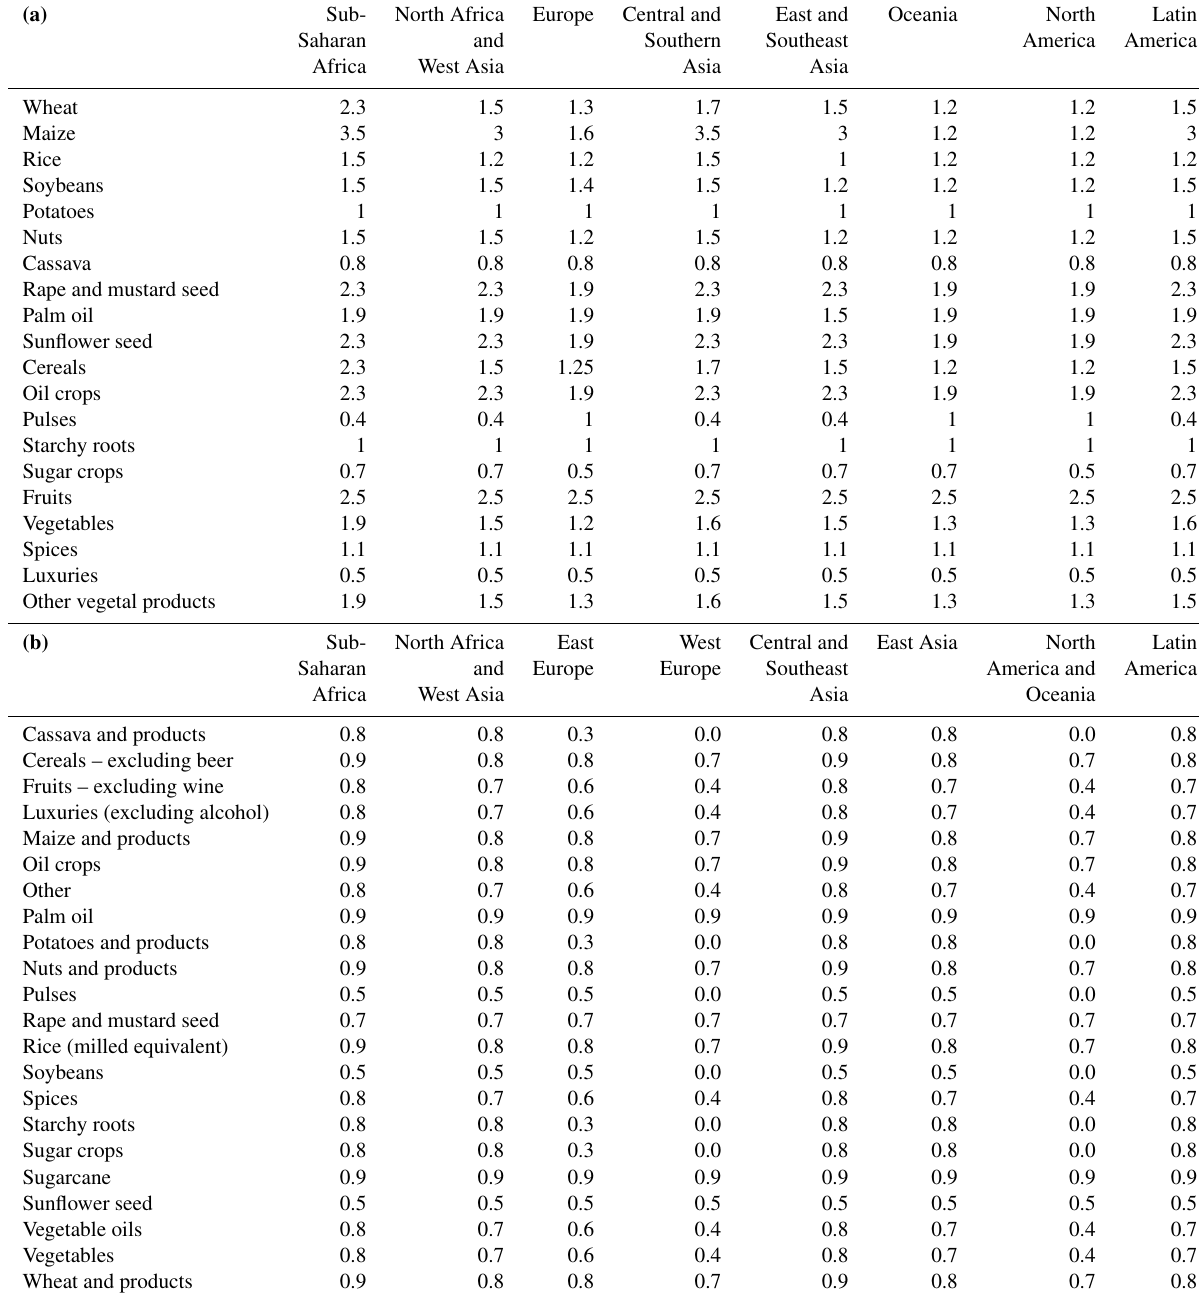
Table B3. (a) Vegetal product harvest factors – the ratio of the mass of useful product to aboveground biomass. Values in this table are adapted from Krausmann et al. (2008). Where a direct mapping was impossible, the average value of other products was used (for example – vegetables). Fruits are assumed to be permanent crops. (b) Vegetable product residue recovery factors – the recovered proportion of potential harvest residues. As with Table B3a, this table is also adapted from Krausmann et al.